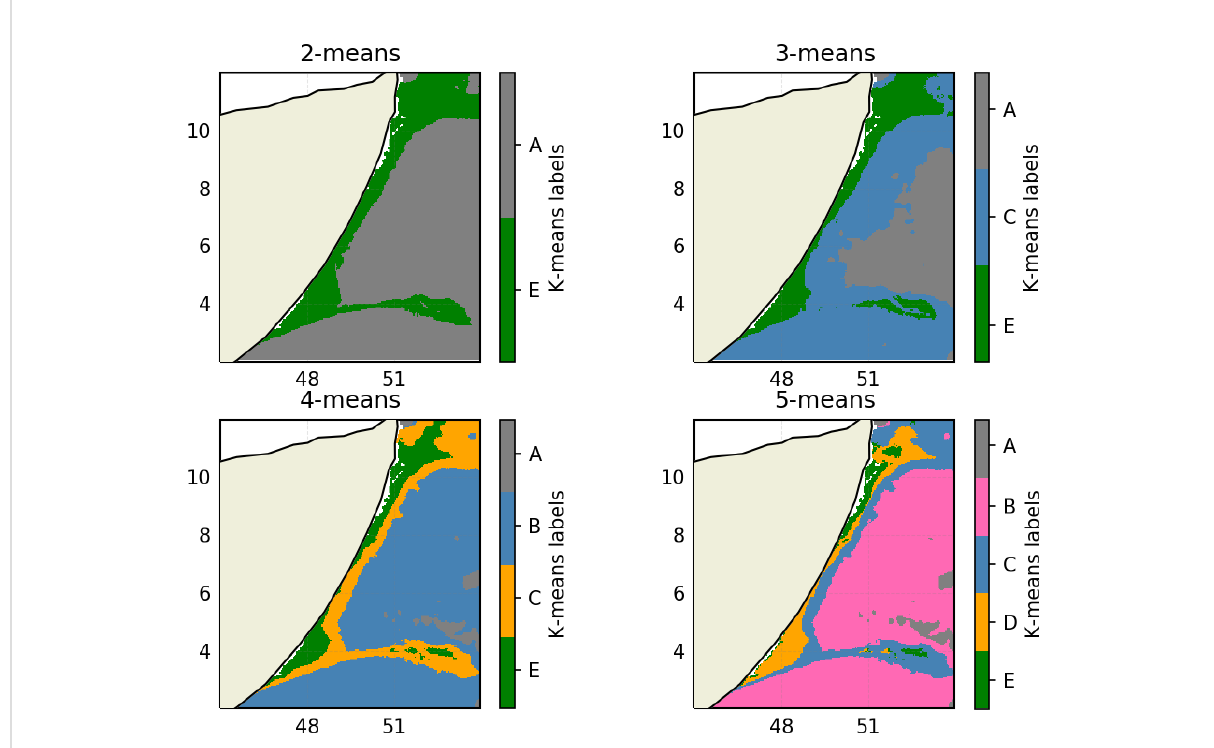
FIGURE 4 Maps showing the regions identi fi ed with clustering, using different numbers of pre-de fi ned clusters corresponding to those shown in Figure 3. This corresponds to the 2-variable model